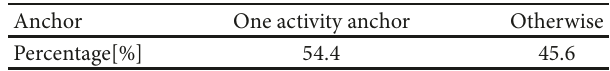
Table 3: Activity anchor of the